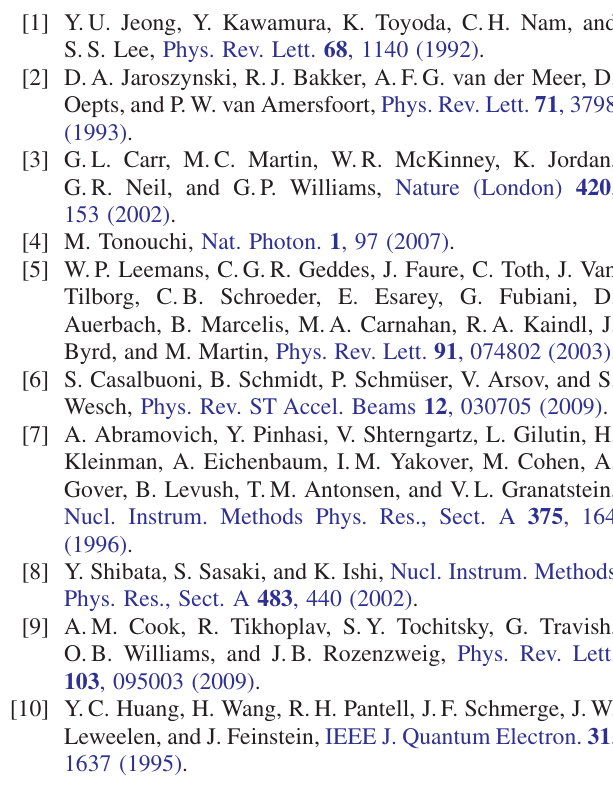
FIG. 5. Radiation accumulated by 100 bunches for case C with N the exact case C amplitude at the same time. (b) Efficiency